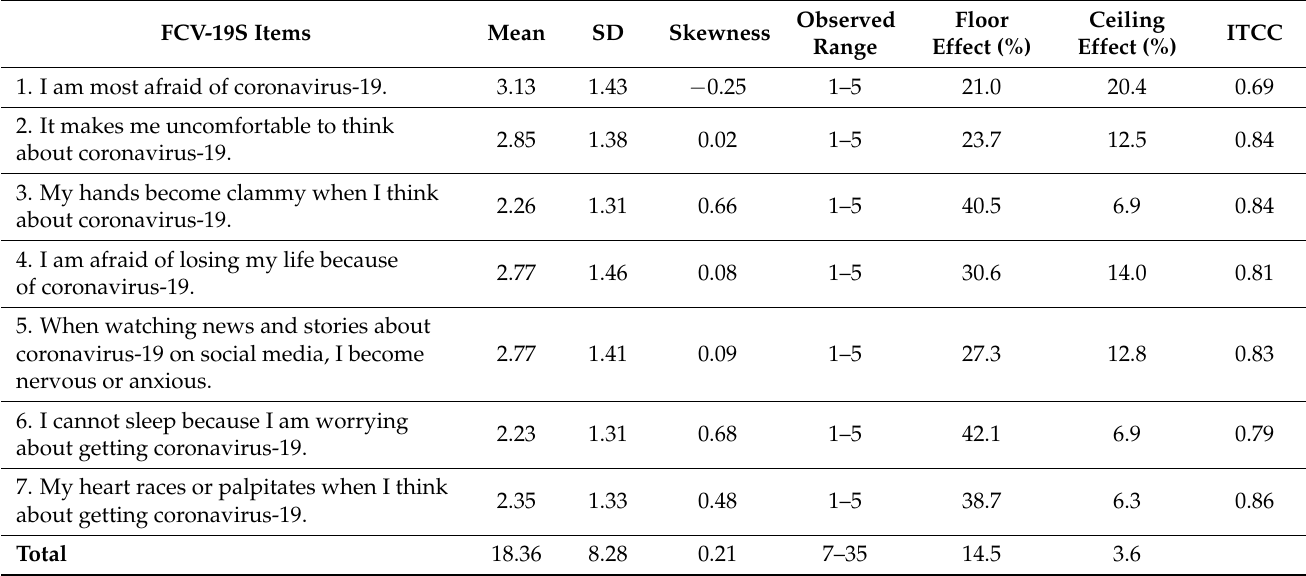
Table 2. Data quality, acceptability and item–total corrected correlation of the FCV-19S (n = 447). FCV-19S Items Mean SD Skewness